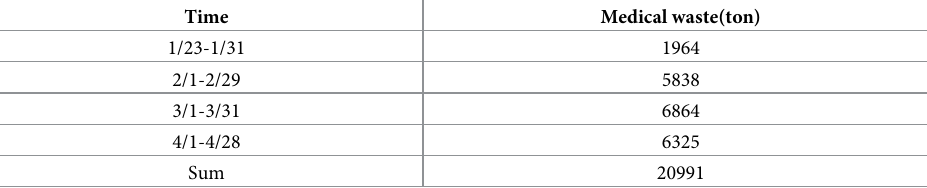
Table 2. Predicted production of medical waste under conventional conditions in the Hubei Province.